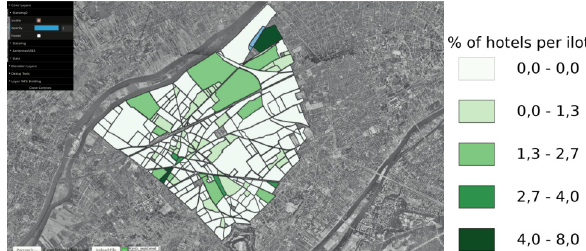
Figure 10. 3D navigation, with visualization of statistics ( ˆ ılot scale) on hotels concentration in Nanterre